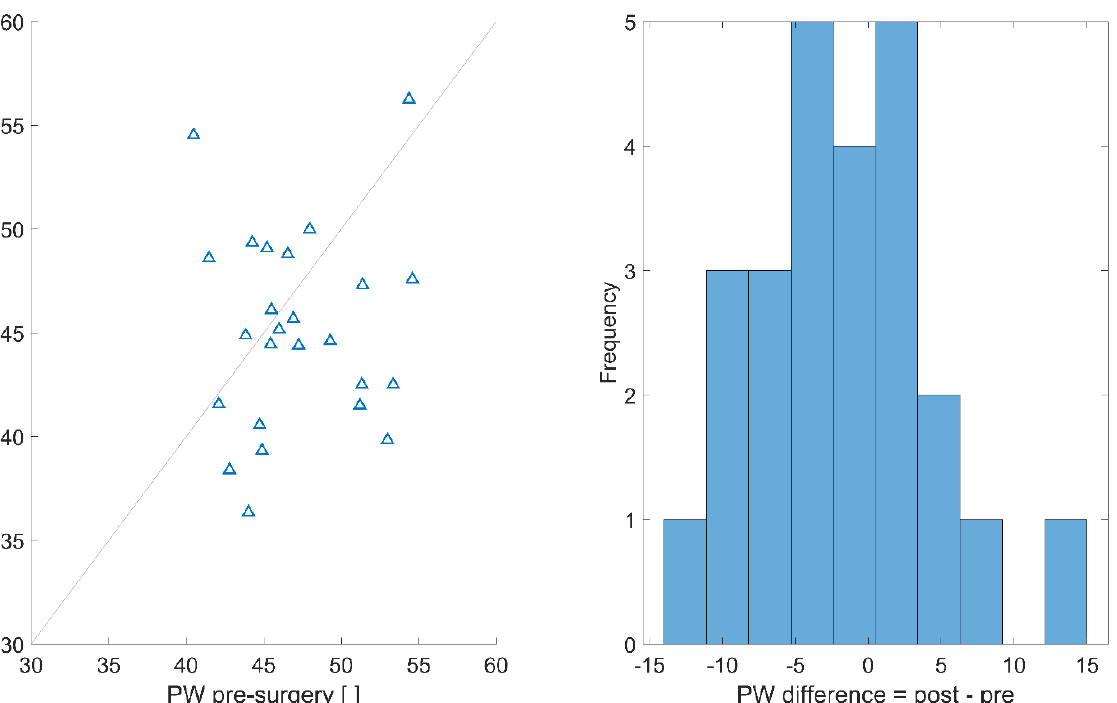
Figure A1. A scatterplot showing percentage weight (PW) data before and after (6 weeks) HTO surgery. The solid line is the one-to-one line. If there was no change between the two tests, the data point would fall on the one-to-one line. Points above this line indicate higher scores following the surgical intervention. △ , HTO individual data.